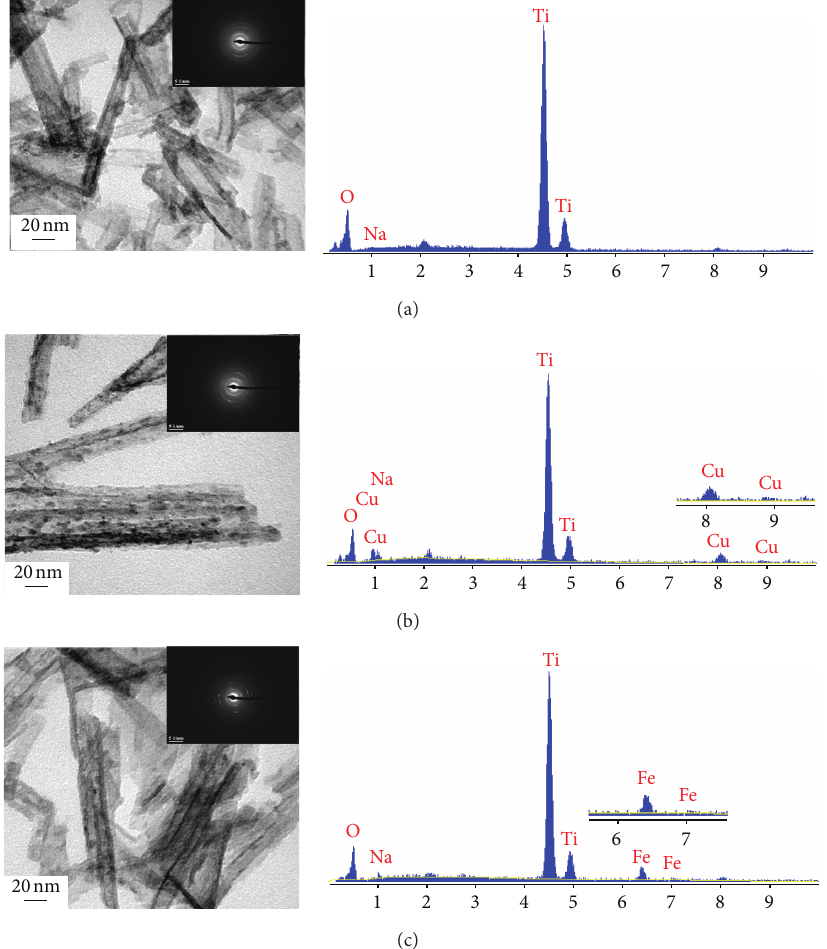
Figure 1: Transmission electron microscopic images, selected area electron diffraction patterns, and energy dispersive X-ray spectra of the (a) TNT, (b) Cu-TNT, and (c)